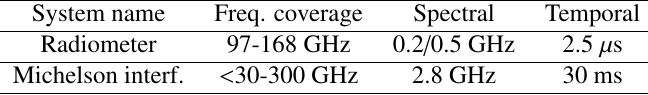
Table 1: The spectral and temporal specifications of the ECE diagnostic on